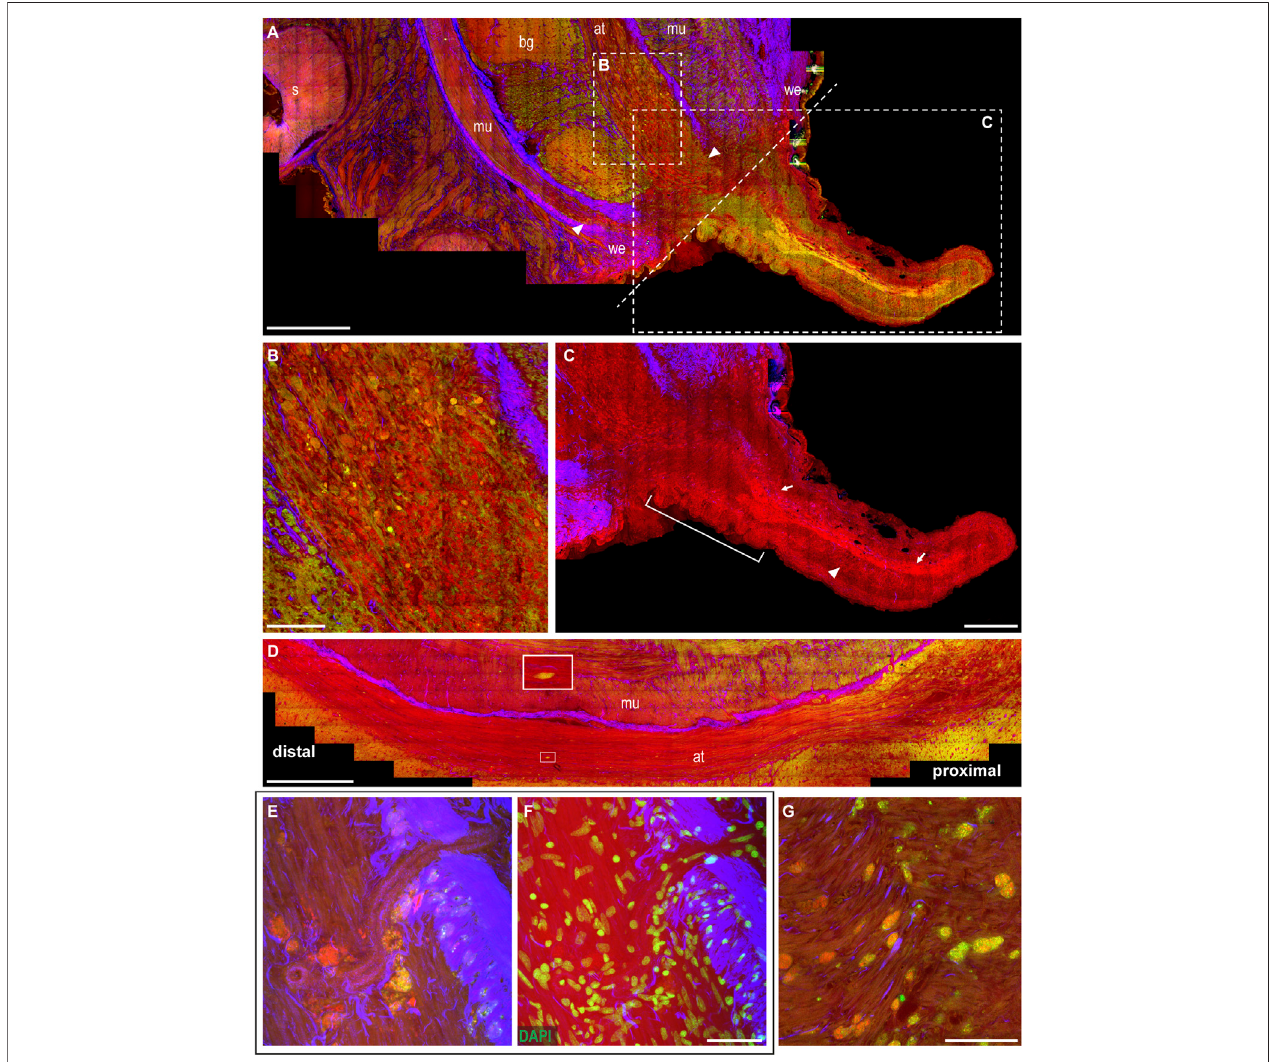
FIGURE 4 | Arm regeneration. (A) Little knob regenerates from the dorsal side of the stump. The wound epithelium narrows around the original site of the lesion, characterized bythick connectivetissue. White dotted linemarksthe originalsite ofthelesion dividingthe stump from theregenerating tip. (B) Degeneration isevident in the axonal tracts of the nerve cord, where fi bers appear swollen and break into lumps (CARS and TPEF). (C) Regenerating fi bers appear among degenerating lumps in the axonal tract (highlighted in CARS) and can be followed providing innervation in the newly forming tip (arrows); thin processes can be seen descending perpendicularlytothese fi bers (arrowhead).Suckers develop at thebaseofthe regenerating arm(white bar). (D) Degenerationcanbefollowedalongtheaxonaltracts:it involves a great number of fi bers proximal to the lesion; few degenerating fi bers can be detected moving distally (see enlargement). (E,F) Large number of cells, whose cytoplasmisrichingranulesemitting inCARSandTPEF,areimagedaccumulating closetobloodvesselwalls.DAPIcounterstaininghighlightedcellnuclei. (G) Cellsrich in granules emitted in CARS and TPEF invade muscle layers in the stump. Scale bars: 500 µm in (A,D) , 100 µm in (B,G) , 250 µm in (C) , and 50 µm in (E,F) . Abbreviations: at, axonal tract; bg, brachial ganglion; mu, muscles; s, sucker; we, wound epithelium.